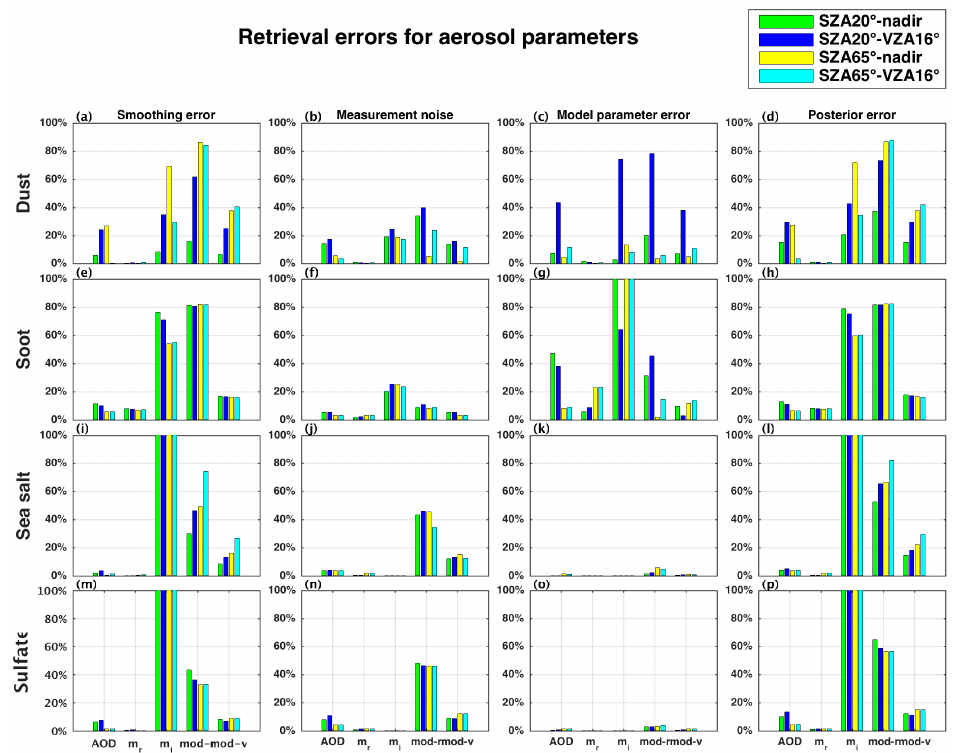
Figure 4. Different error estimates (1 σ ) of aerosol parameters at different observation geometries for all aerosols. Each row represents one type of aerosol: dust ( a – d ), soot ( e – h ), sea salt ( i – l ) and sulfate ( m – p ), respectively. The range of ordinate represents percentage. Remote Sens. 2017 , 9 , 183